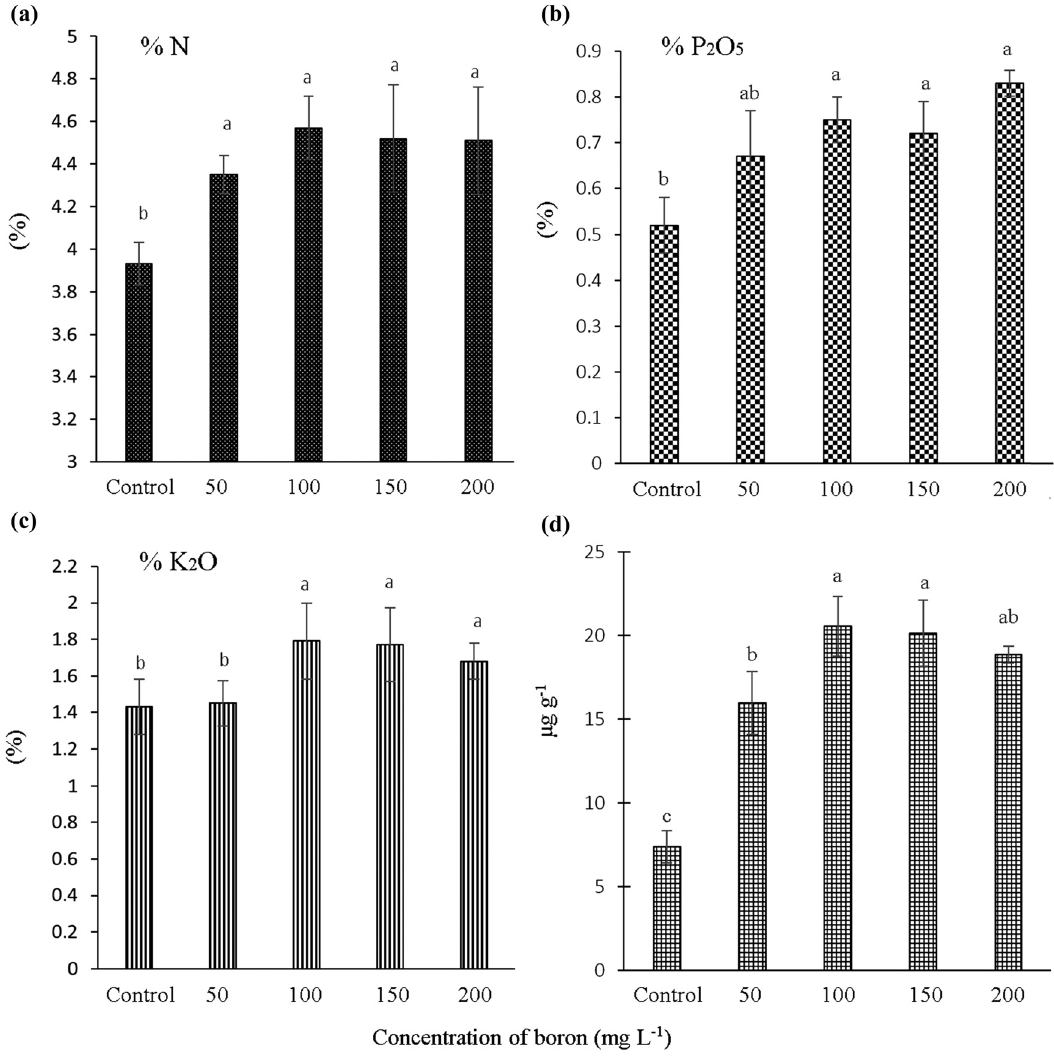
Figure 3: E ff ect of boron on the percentage of N ( a ) , P 2 O 5 ( b ) , K 2 O ( c ) and boron ( d ) in leaves Letters within the columns represent a signi fi cant di ff erence ( P < 0.05 )